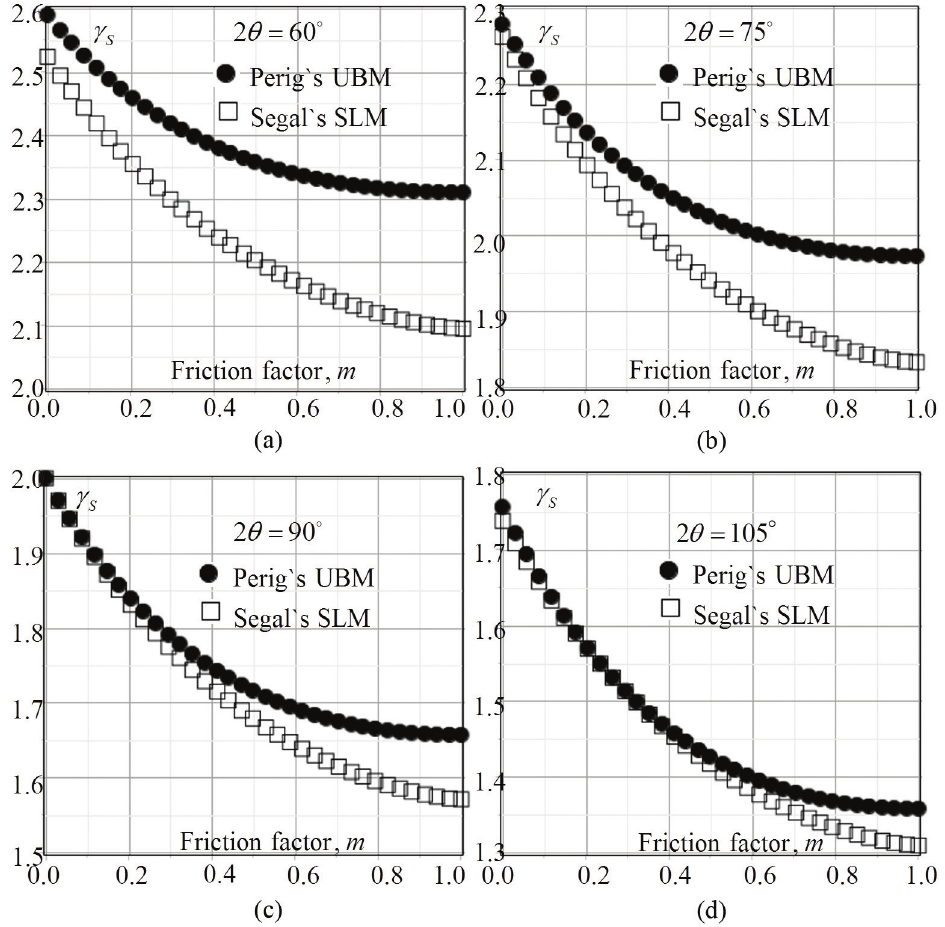
Figure 7. Comparison of Perig’s upper bound (UBM, ●●●) and Segal’s slip lines (SL, □□□) solutions for different values of friction factor m . Computational dependencies for summary plastic shear g ( a – d ) with respect to the friction factor m , derived with UBM and S slip line method (SLM) during ECAE of non-hardening material through Segal dies with channel intersection angles 2 θ =60 ° ( a ), 2 θ =75 ° ( b ), 2 θ =90 ° ( c ), and 2 θ =105 ° ( d ).